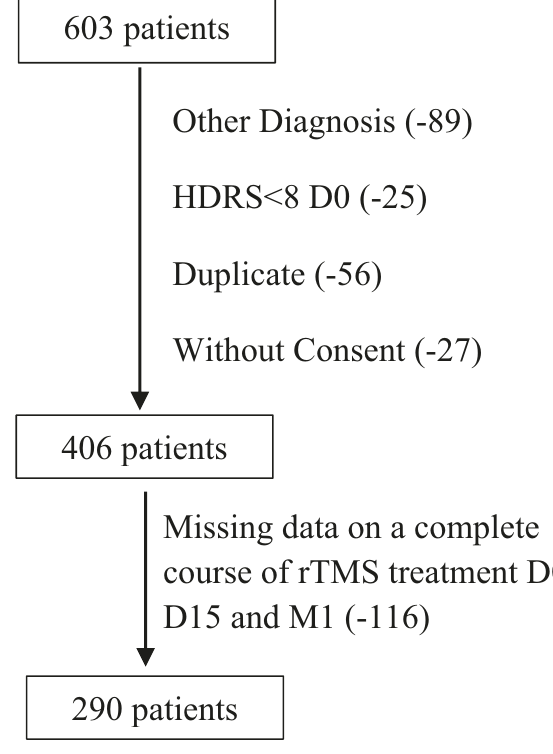
Fig. 1 Flow chart of the